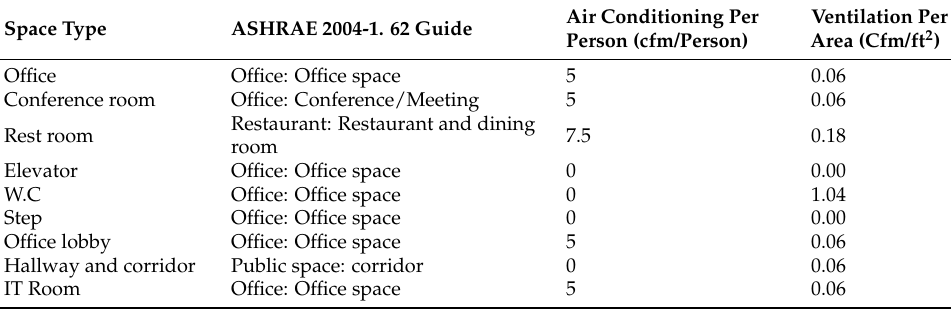
Table 2. Default settings of air flow coefficients in calculating heat loads